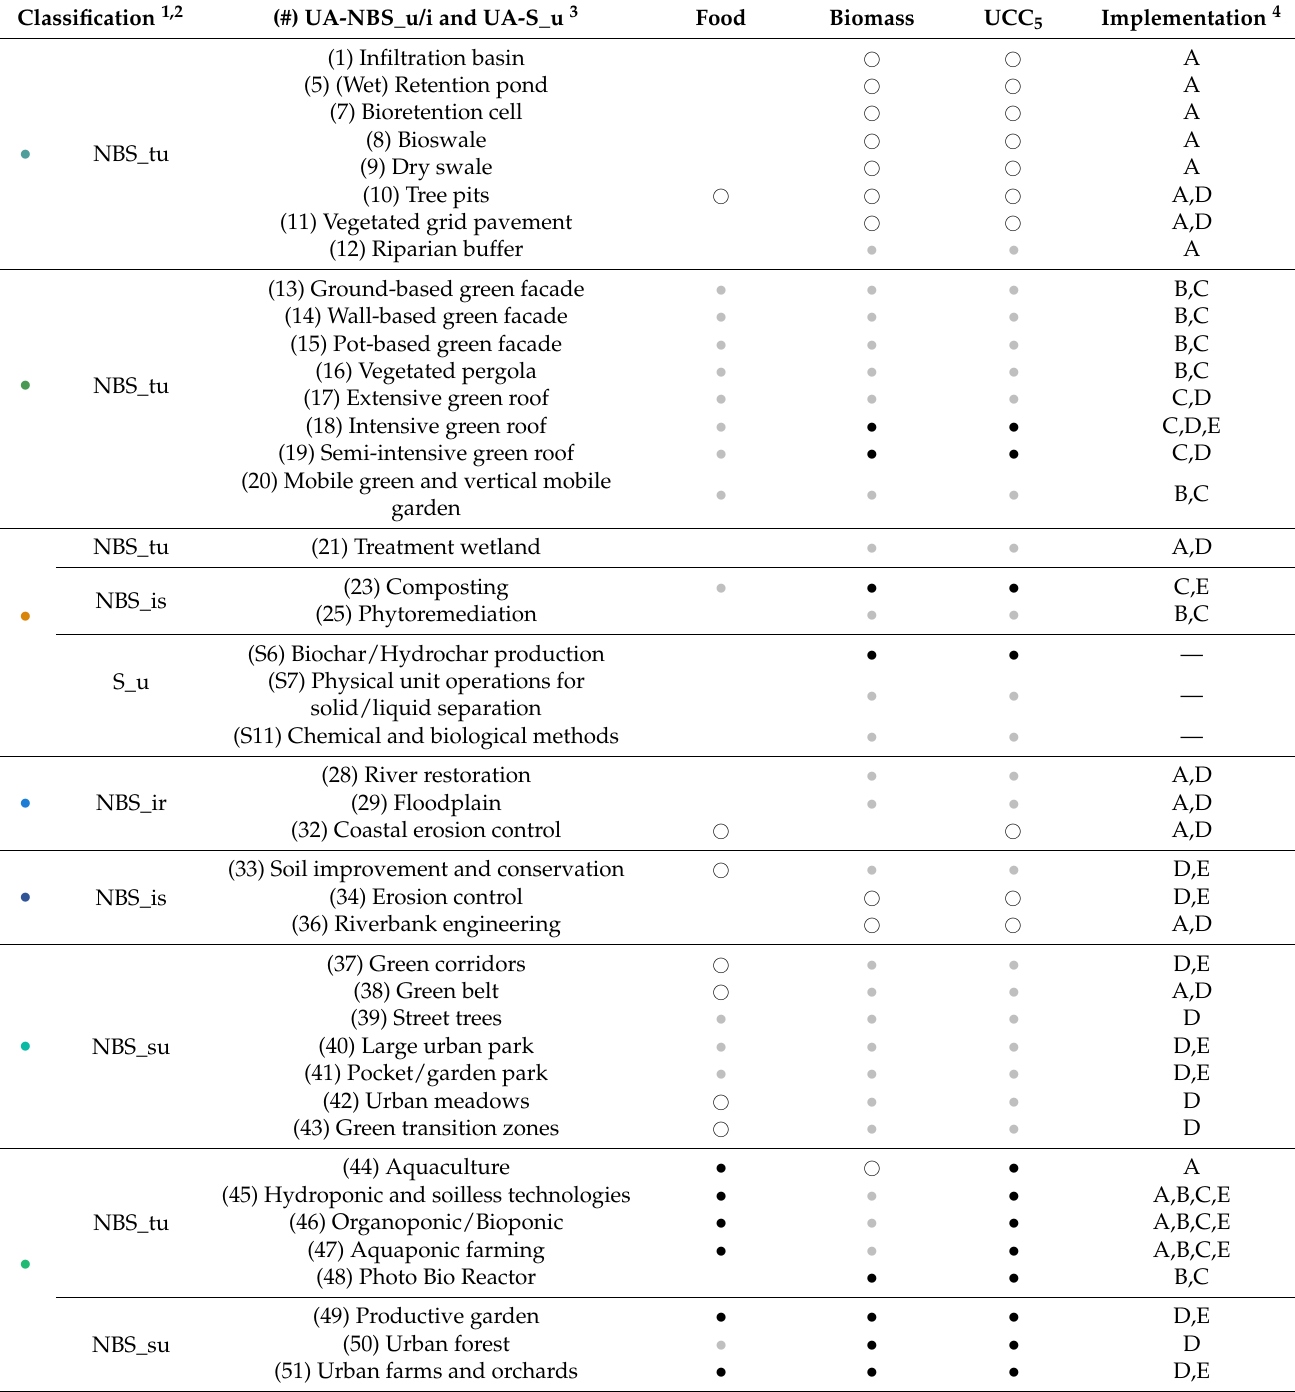
Table 2. Selected urban agriculture related NBS units and interventions (UA-NBS_u/i) and supporting units (UA-S_u), addressing the fifth urban circularity challenge on “Food and biomass production” (UCC 5 ) [5,6]: • addressing the UCC 5 by food production, biomass production, and food and biomass production (score = 1.00); • contribution and o potential contribution to the UCC 5 depending on specific design (scores = 0.66 and 0.33, respectively). Empty cells are those UA-NBS_u/i and UA-S_u not addressing the UCC 5 via food or biomass